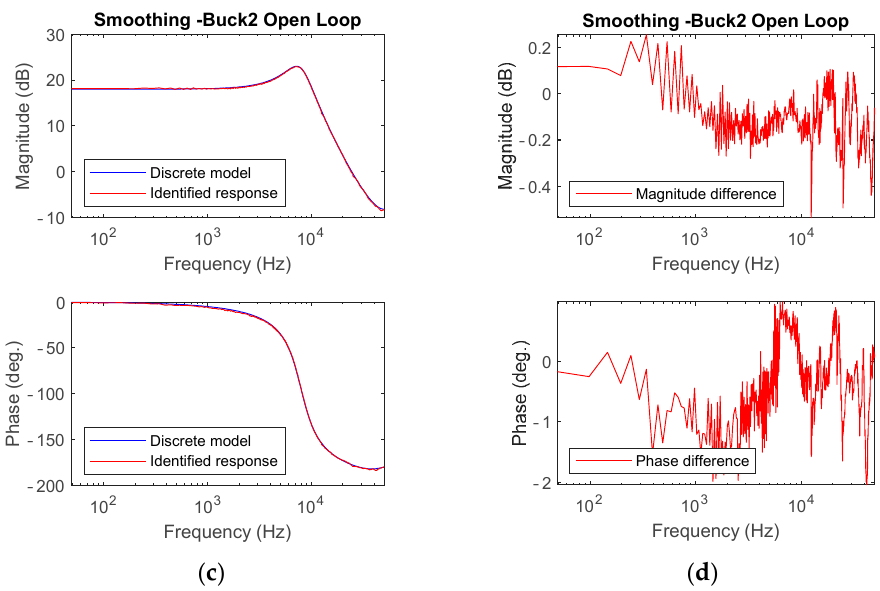
Figure 11. Buck converter open-loop results. ( a ) Bode plot without smoothing process. ( b ) Difference between discrete theoretical model and experimental measurements without smoothing process. ( c ) Bode plot with smoothing process. ( d ) Difference between model and measurement with smoothing process.